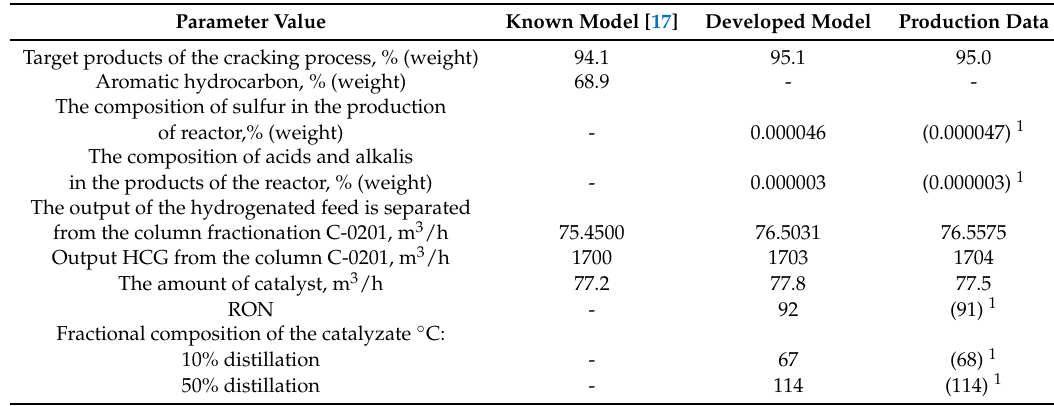
Table 2. Comparison of simulation results using well-known deterministic models,based on expert information and experimental production data of the reactor of the Atyrau Oil Refinery’s catalytic cracking unit.